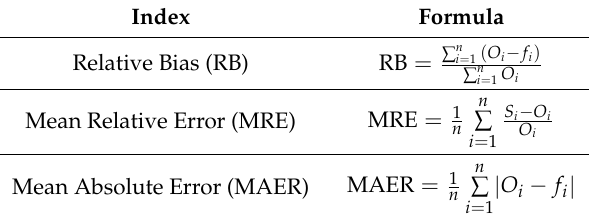
Table 2. Statistical measures used to evaluate the performance.